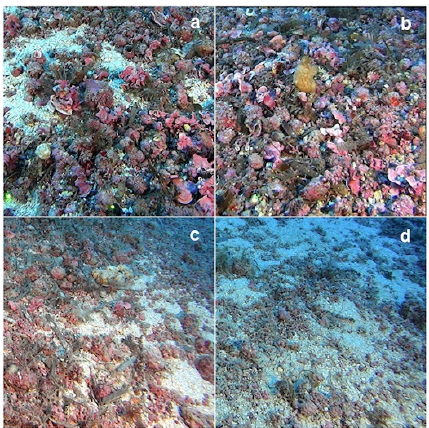
Figure 5. ROV image of lamellar thalli ( a , b ) in S3 sampling site and white ones in S2 ( c ) and S5 ( d ) sampling sites, among the rhodolith/maërl bed in Lampedusa Island.